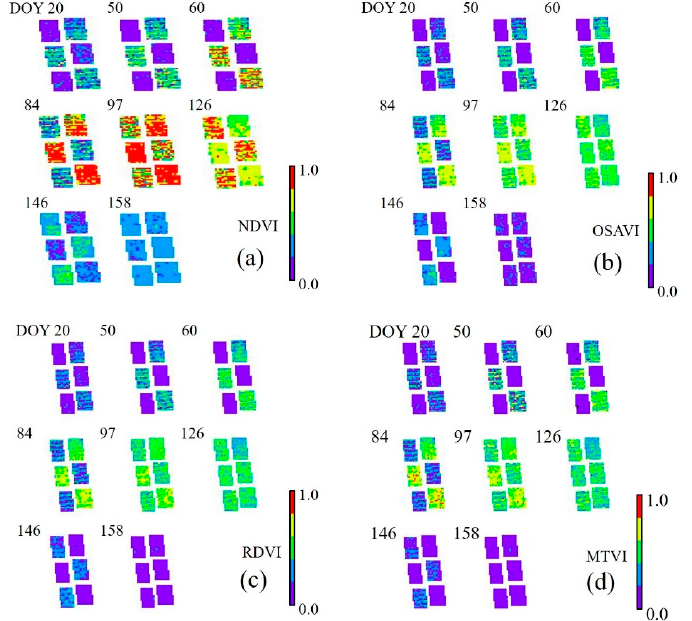
Figure A6. Variations in observed barley vegetation indices at the Gyeongsang National University field in 2021. NDVI, normalised difference vegetation index ( a ), OSAVI, optimised soil-adjusted vegetation index ( b ), RDVI, re-normalised difference vegetation index ( c ), and MTVI, modified triangular vegetation index ( d